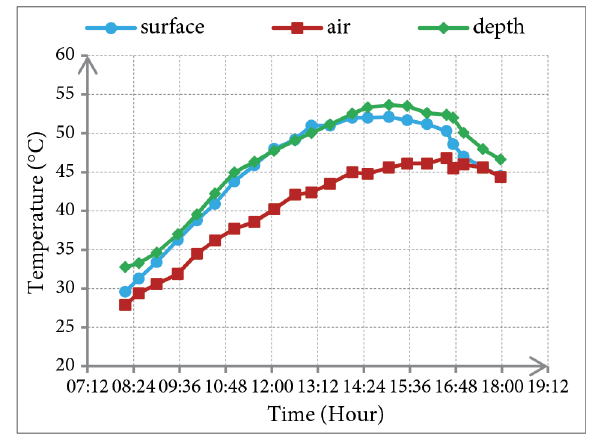
Figure 7. Air, surface and depth temperature variations in